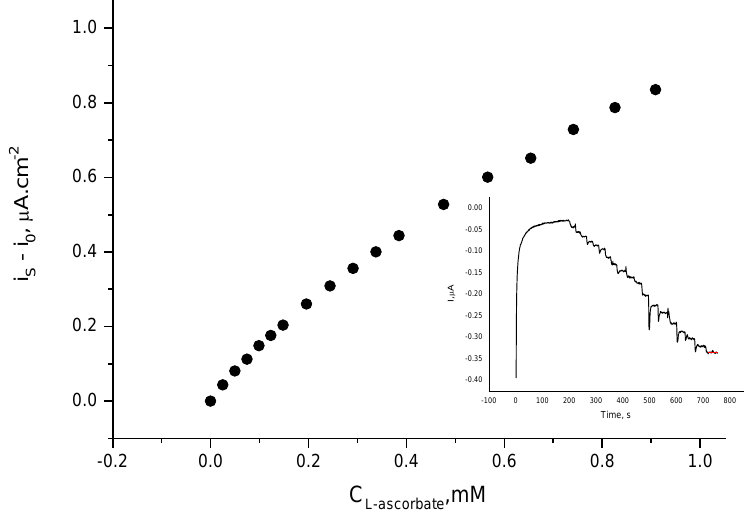
Figure 9. Current density variation of laccase biosensor upon addition of L-ascorbic acid aliquots at 0 V (vs. Ag|AgCl, sat. KCl); electrolyte: 0.05 M citrate buffer with 0.1 M NaClO 4 , pH = 4.0; temperature 21 ± 1 °C. Inset: Authentic record.